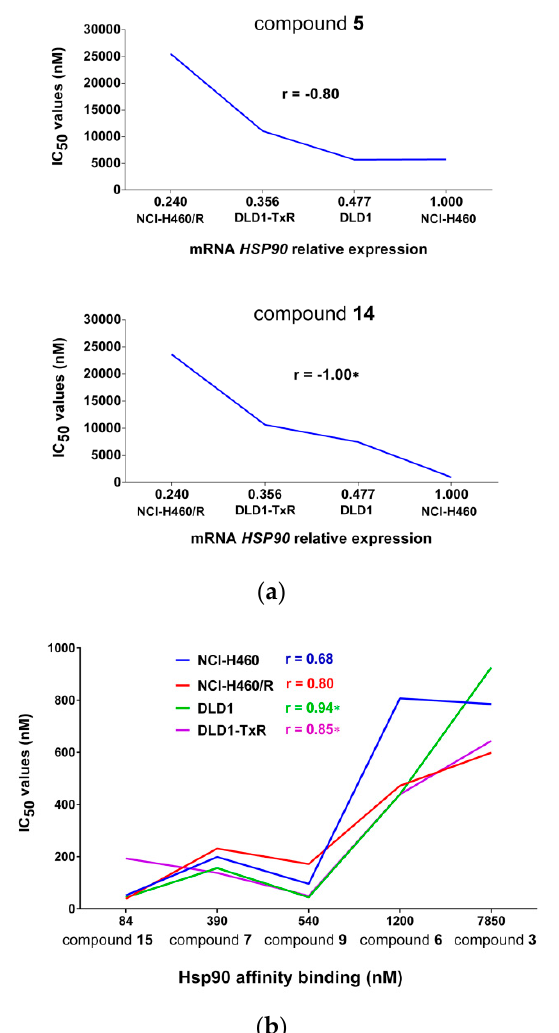
Figure 2. Cell growth inhibition potential of Hsp90 inhibitors correlates with the level of Hsp90 expression and Hsp90 affinity binding. ( a ) Negative correlation between IC 50 values and mRNA HSP90 relative expression. Spearman correlation indicates that the effect of compounds 5 and 14 on growth inhibition is stronger in cell lines with higher mRNA HSP90 expression ( r = Spearman’s correlation coefficient). Statistical significance: p < 0.05 (*) ( b ) Positive correlation between Hsp90 inhibitors’ effect on cell growth inhibition and Hsp90 affinity binding. Pearson correlation is applicable only for Hsp90 inhibitors with strong e ff ect on cell growth (IC 50 < 1000 nM). ( r = Pearson’s correlation coe ffi cient). Statistical significance: p < 0.05